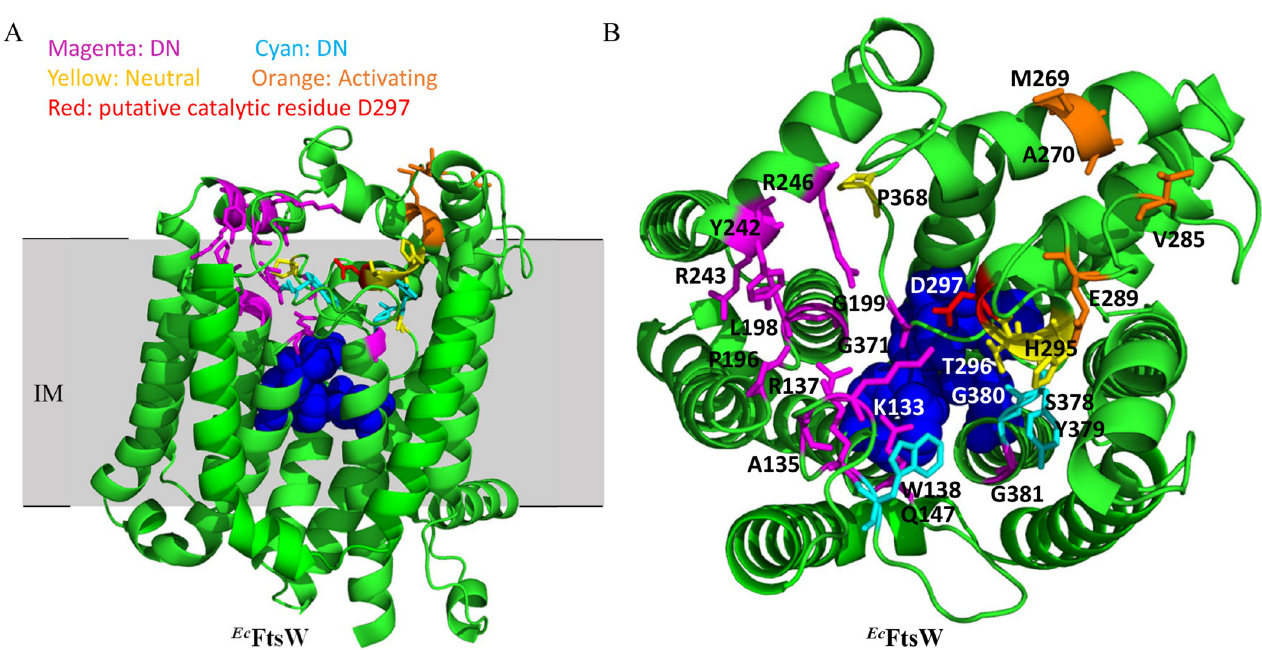
Fig 3. Location of the dominant-negative ftsW mutations on a structural model of FtsW. (A) and (B) Locations of dominant-negative mutations in a model of E . coli FtsW predicted by AlphaFold2 (45). Residues corresponding to the dominant-negative mutations are colored magenta (obtained by wrinkled-colony- based screen) or cyan (obtained by site-directed mutagenesis), whereas residues whose alanine substitution did not display a defect are colored yellow. The putative catalytic residue D297 is colored red, activating mutations are colored orange. Residues corresponding to those flanking the central cavity of RodA are colored blue and shown as spheres. The N-terminal 15 and C-terminal 10 amino acids are